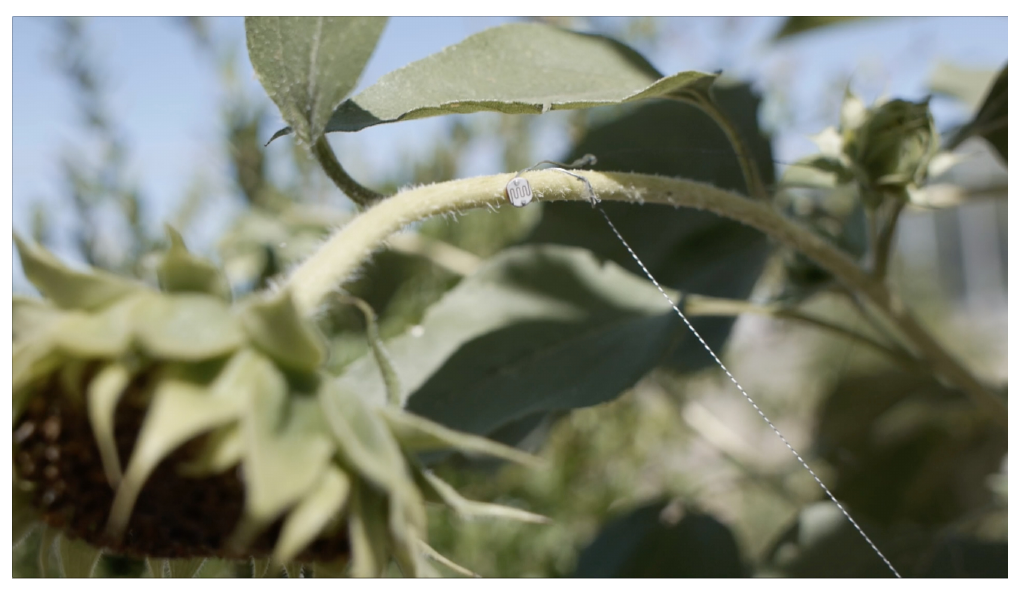
Figure 7. Sunflower embedded with photoresistor and conductive